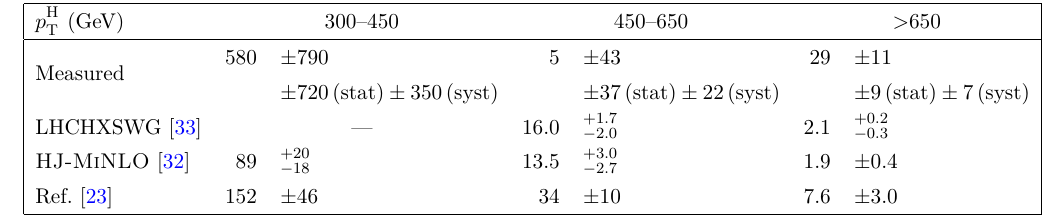
Table 4 . Measured and predicted ggH differential fiducial cross section as a function of Higgs boson p . All cross sections are in units of fb. The cumulative cross section predictions from ref. [33] T are converted to differential cross section predictions by subtraction assuming the cumulative cross section uncertainties are fully correlated.